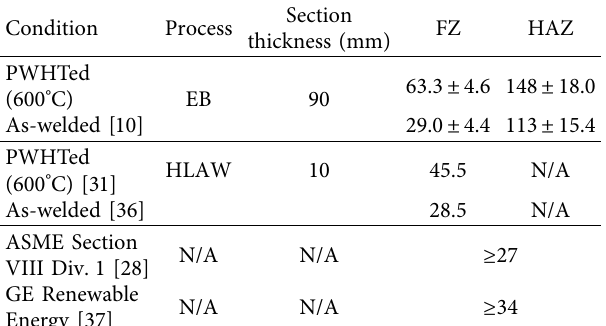
Table 7: Comparison of the average Charpy impact energies (J) for